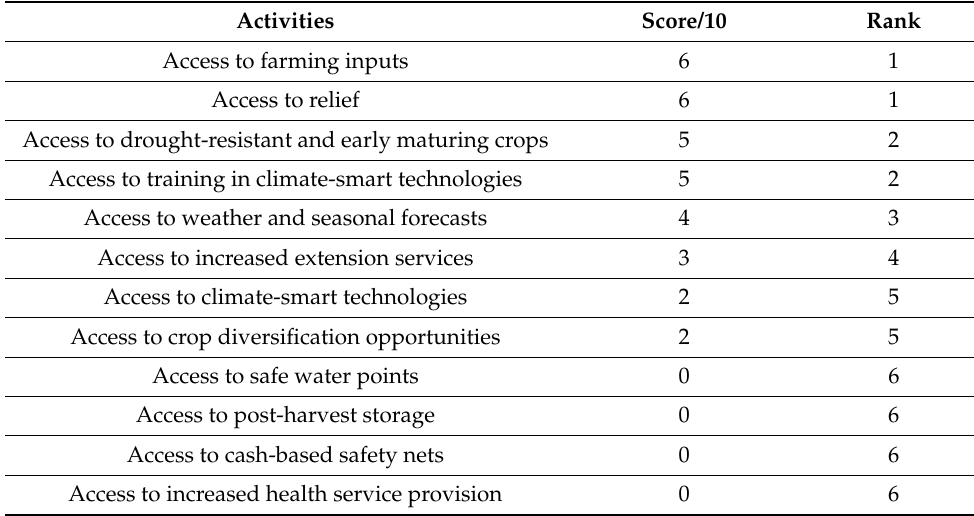
Table 2. A summary of benefits received by smallholder farmers as part of disaster preparedness in the cereal value